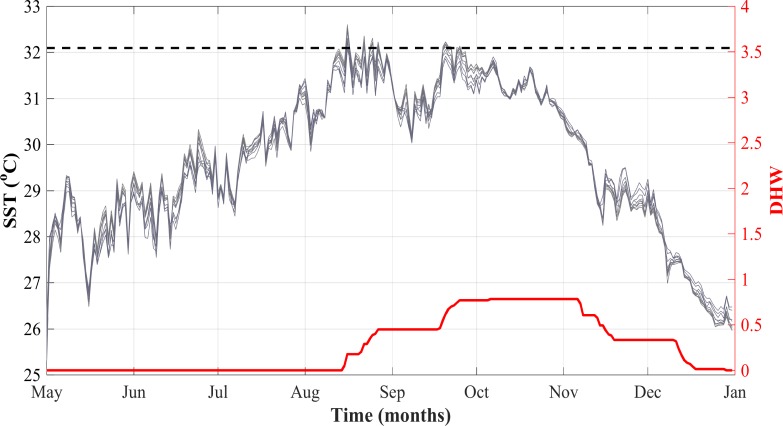
Sea surface temperature (SST), degree heating weeks (DHWs), and bleaching threshold at each reef location from May 1, 2015 to December 31, 2015.SST is represented by the gray shaded lines and the bleaching threshold temperature (averaged across all 11 reefs) is shown by the dashed black line. Both temperature values are shown in °C. The averaged DHWs across all 11 reefs are depicted by the solid red line. All data was downloaded from NOAA’s CRW 5km daily product [28].